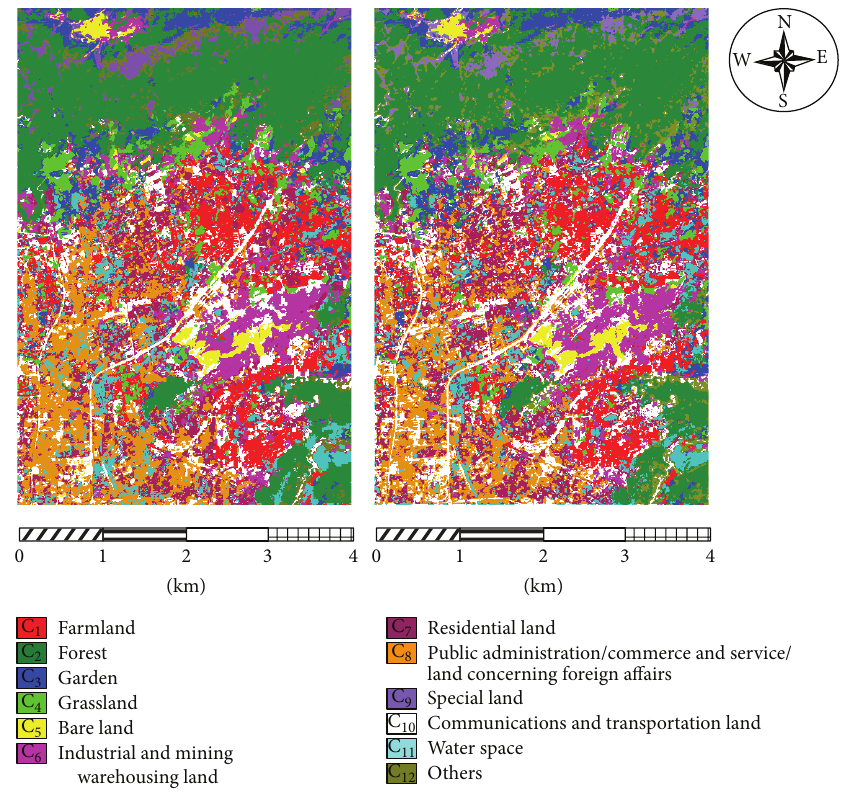
Figure 8: Comparison of BDT-SMO classification based on SRBF and CRBF (zone 1).